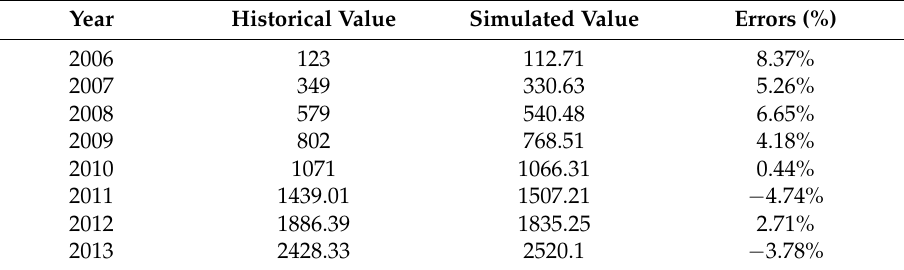
Table 3. Simulated errors of the accumulated proved resource (billion cubic meters).